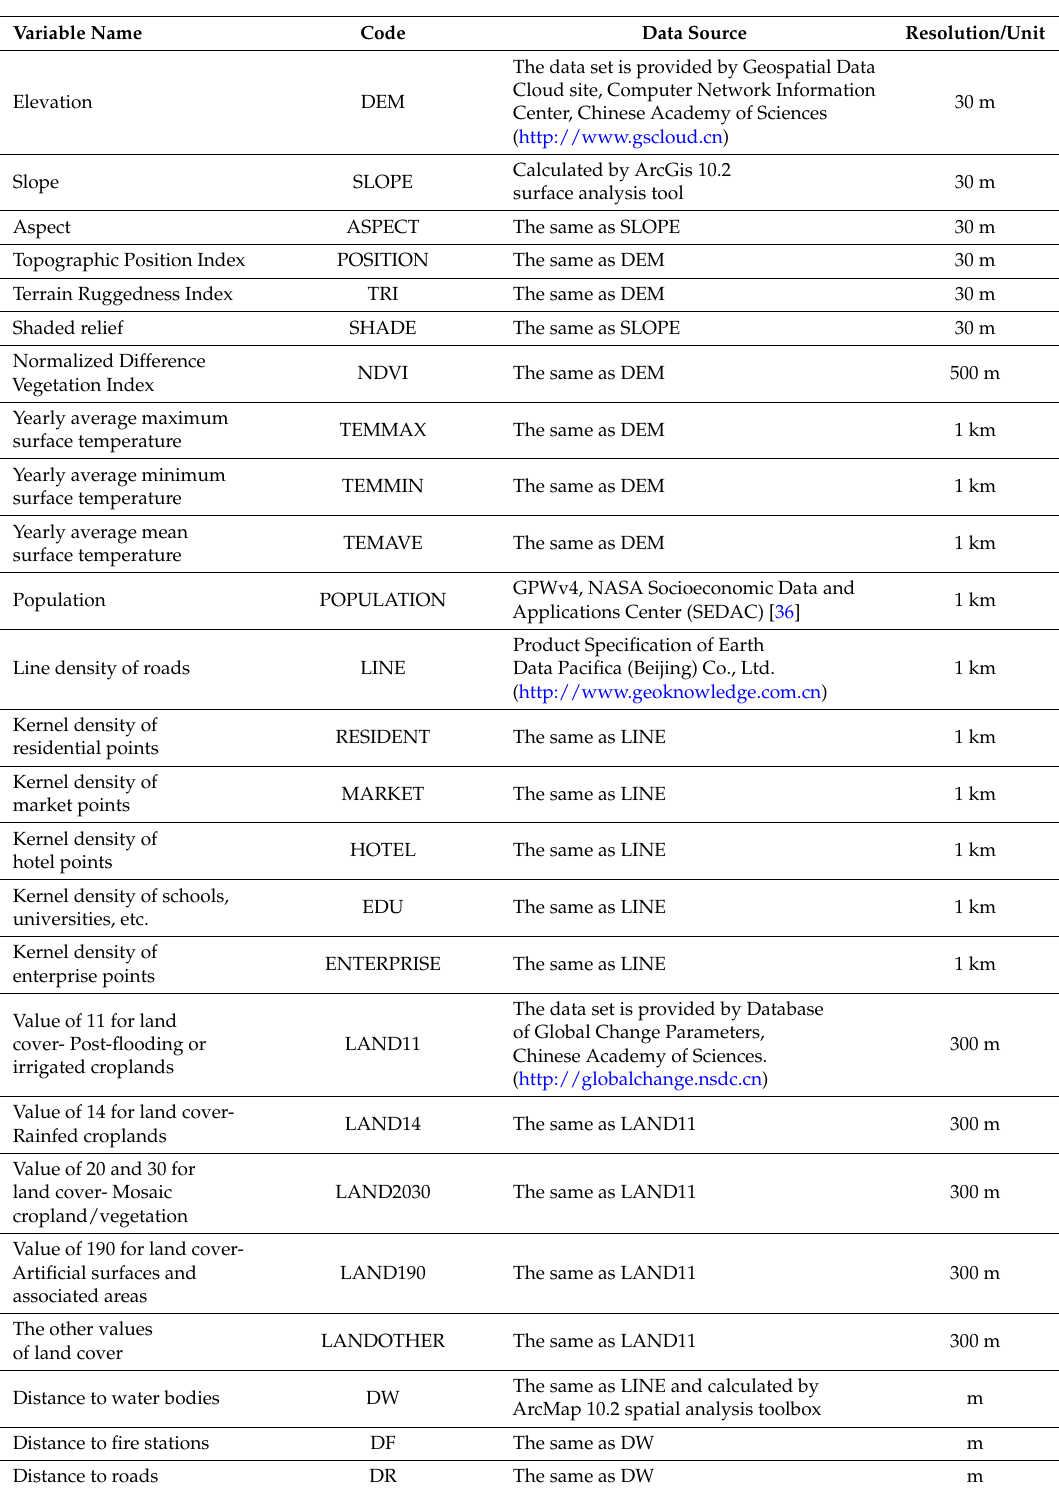
Table 2. Candidate explanatory